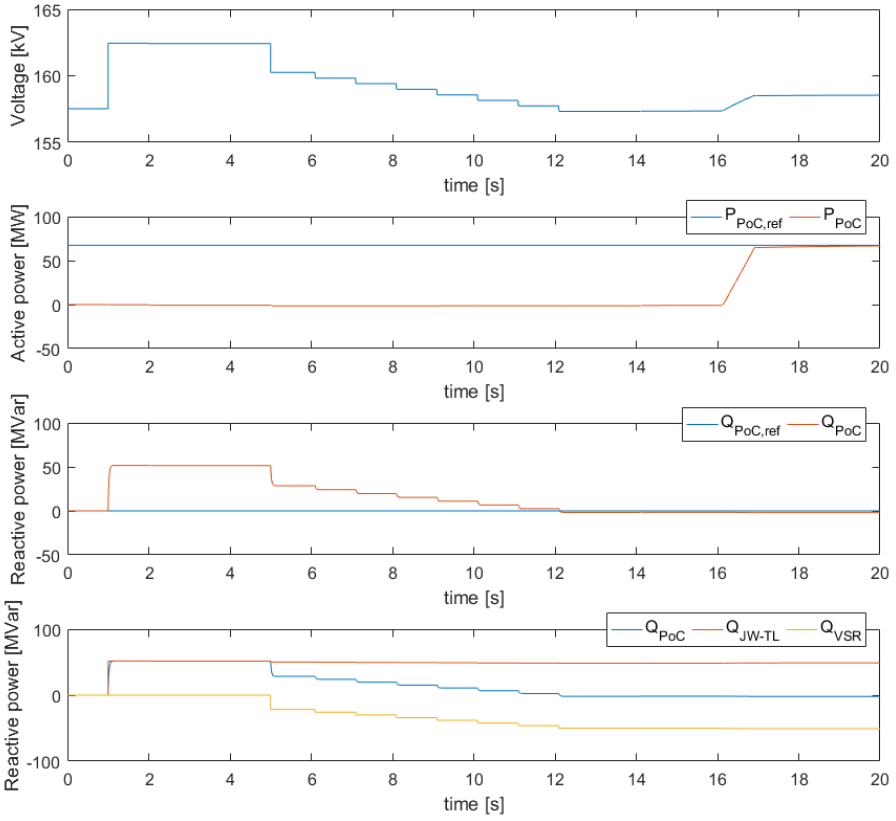
Figure 13. Reactive power capability by the reactive power control